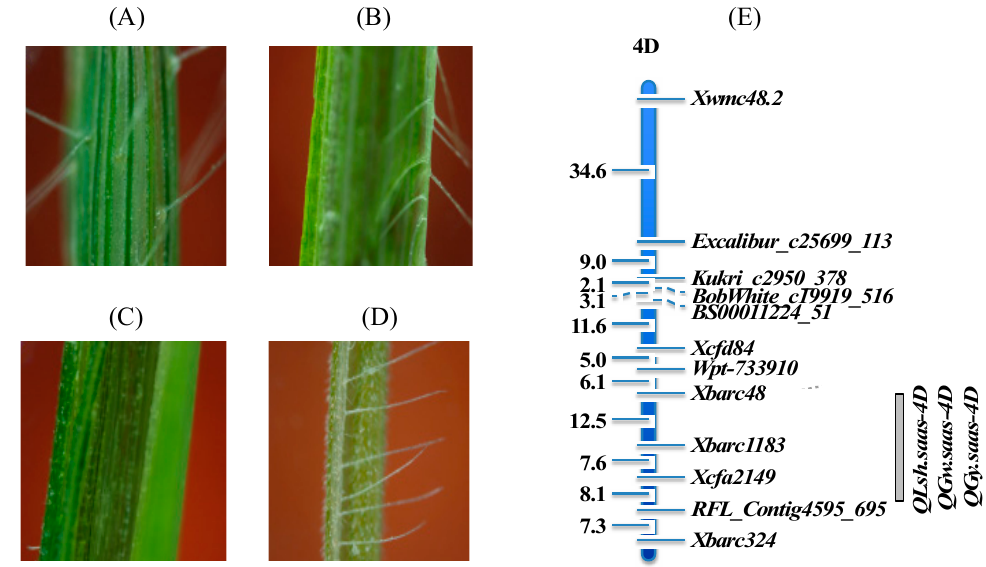
Figure 3. Hairy leaf sheaths from SHW and its association with grain yield. Leaf sheaths of ( A ) Chuanmai 42, ( B ) Syn769, ( C ) common wheat, and ( D ) Ae. tauschii ; ( E ) QTL mapping for LSH, and grain yield (GY) and weight (GW).